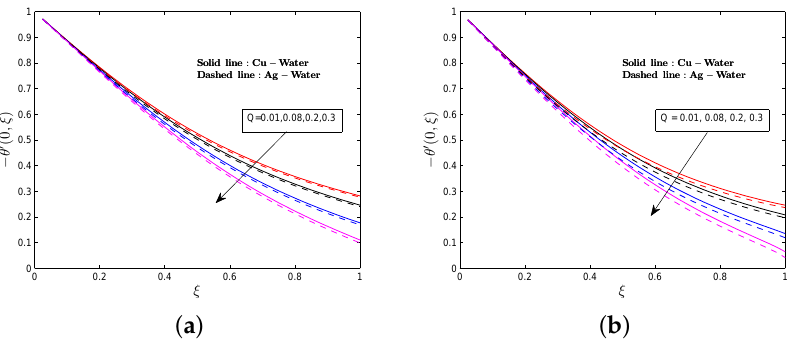
Figure 18. Heat transfer rate for various values of Q . ( a ) vertical plate; ( b ) horizontal